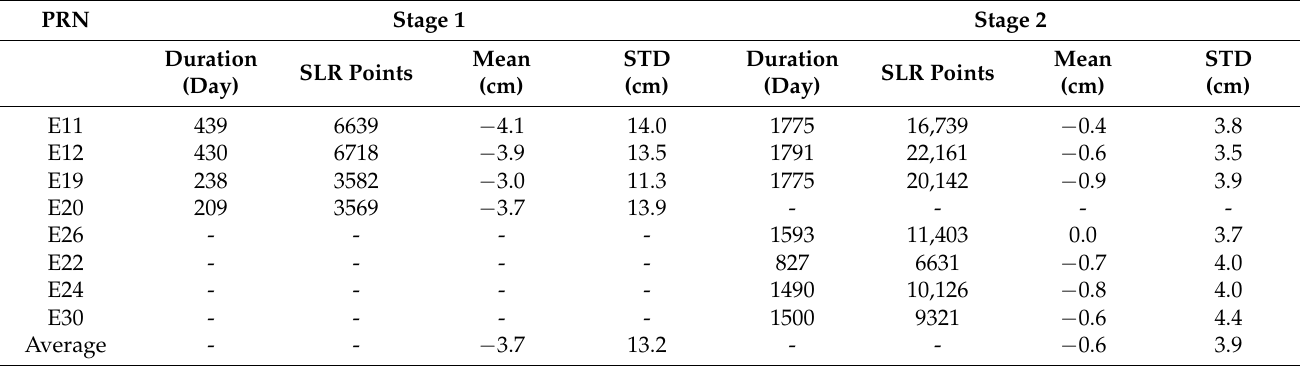
Table 9. Statistical information for SLR residuals calculated from GRM orbits.